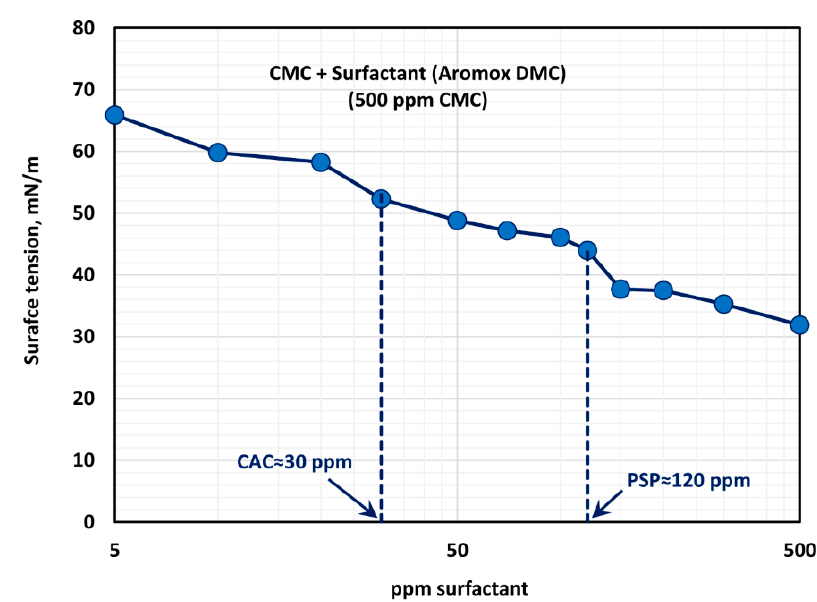
Figure 16. Variation of surface tension of surfactant-polymer solutions with the increase in surfactant (Aromox DMC) concentration, at a fixed polymer (CMC) concentration of 500 ppm.